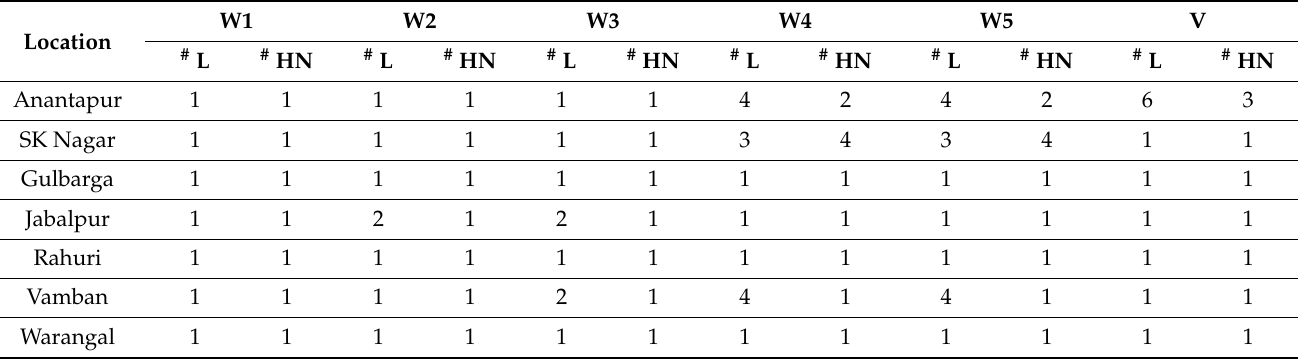
Table 7. Selection of W–ANN model based on